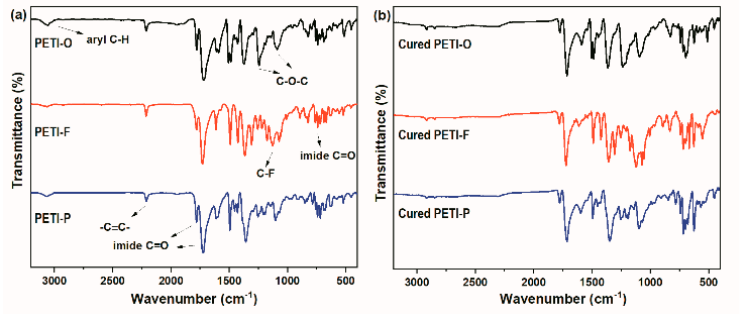
Table 1. Physical properties of uncured oligoimides. Figure 1. Representative FT-IR spectra of ( a ) phenylethynyl-terminated polyimides (PETIs) and ( b ) the corresponding cured PETIs.